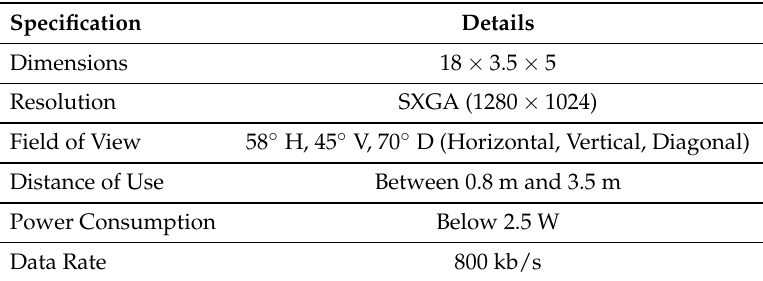
Table 1. RGB-D camera